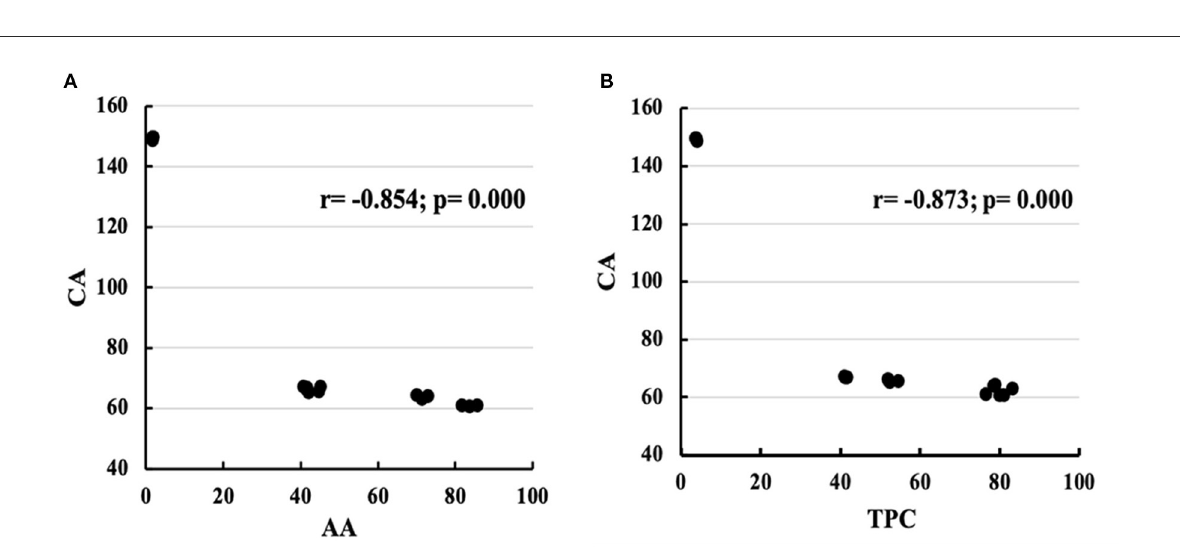
FIGURE5 Analysis of correlation, (A) CFT vs. CA and (B) AA vs.